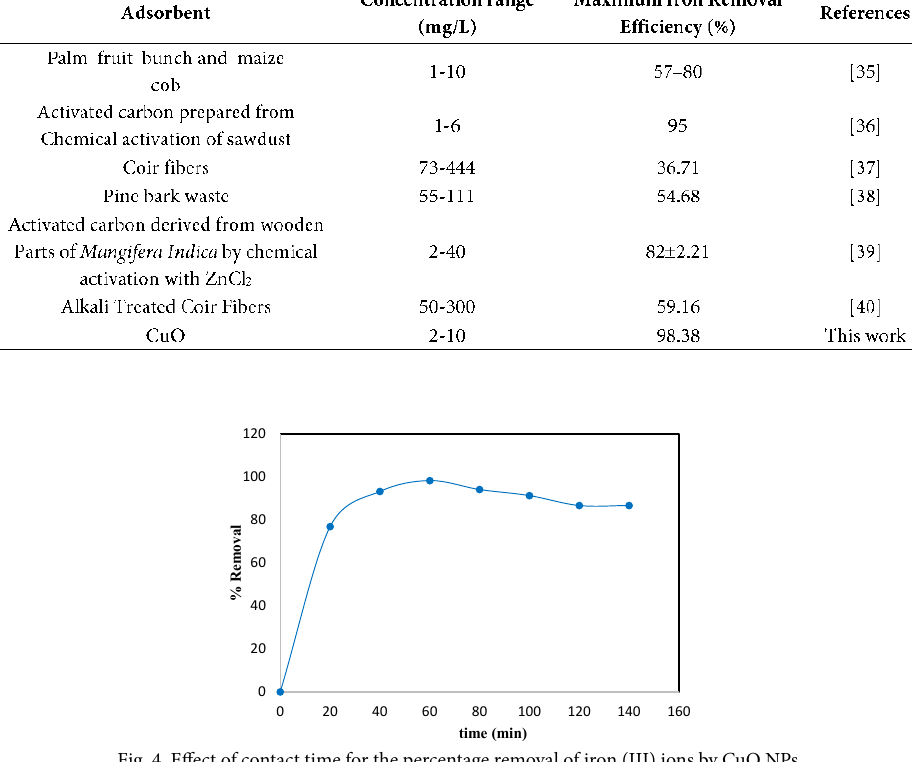
Fig. 4. Effect of contact time for the percentage removal of iron (III) ions by CuO